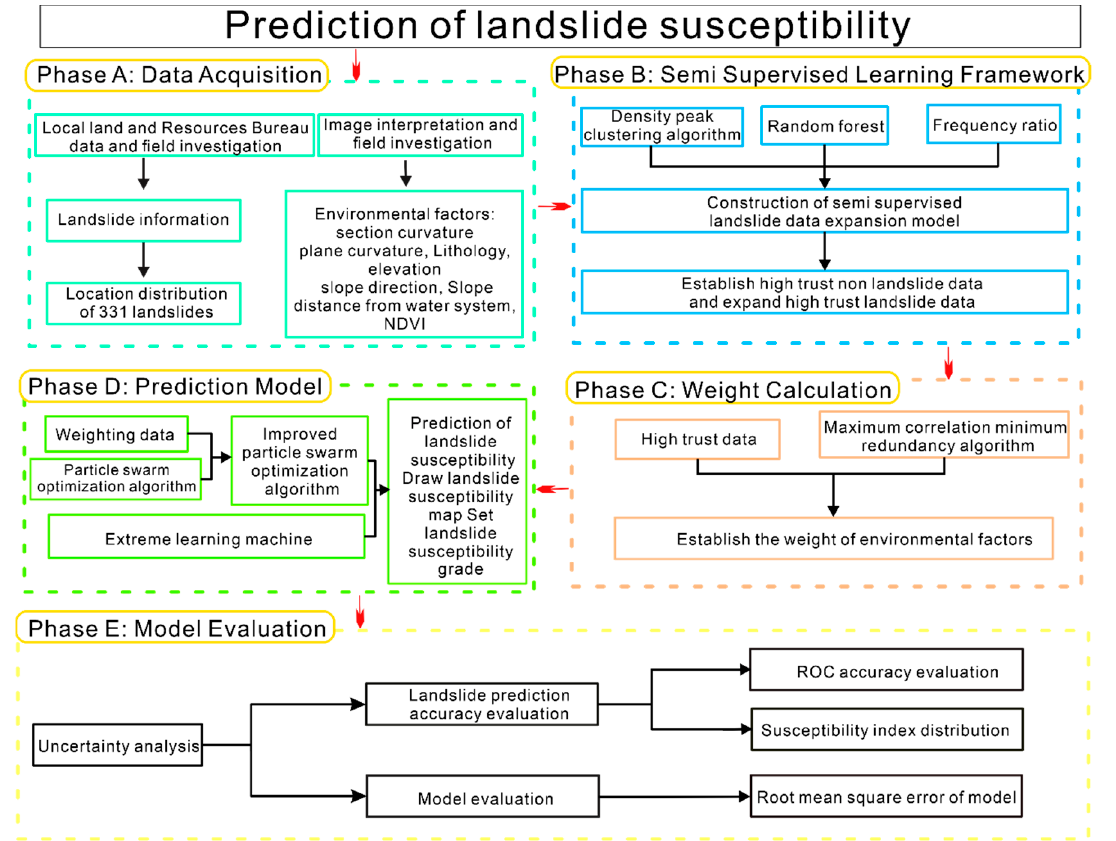
Figure 3. Landslide susceptibility prediction modeling flowchart.